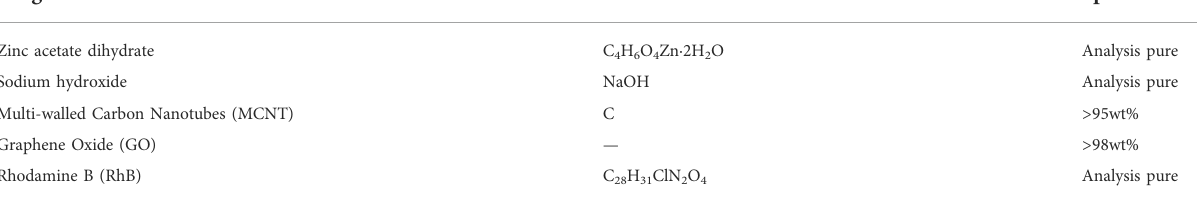
TABLE 1 The chemical reagent for preparing the